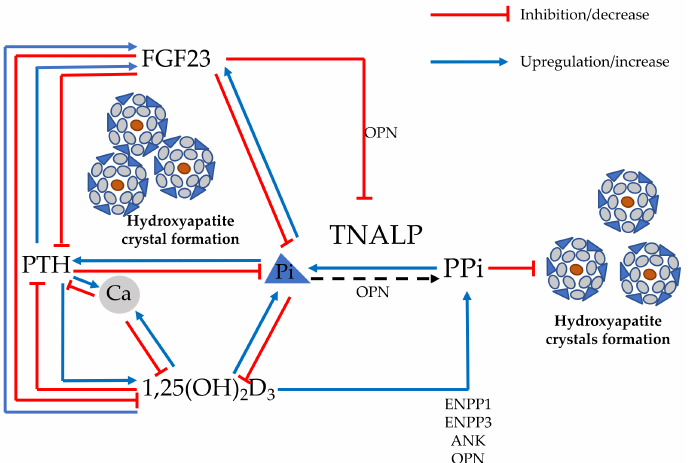
Figure 1. Graphic description of the endocrine and paracrine regulation of the biomineralization pro- cess in and around osteoblast and osteocytes and schematic representation of homeostasis feedbacks. Parathyroid hormone (PTH) and fibroblast growth factor 23 (FGF23) and phosphaturic hormones decrease serum Pi concentration, while 1,25-dihydroxy vitamin D 3 [1,25(OH) 2 D 3 ] increases serum Ca and Pi via active intestinal absorption through activation of the vitamin D receptor. These hormones are reciprocally regulated by negative feedback systems. Tissue non-specific alkaline phosphatase (TNALP) processes inorganic pyrophosphate (PPi), a major inhibitor of mineralization, turning it into Pi, which makes it available for hydroxyapatite crystal formation. At the same time, TNALP depohos- phorylates and activates osteopontin (OPN), which, in turn, inhibits mineralization, increasing PPi. Other mineralization inhibitors include ectonucleotide pyrophosphatase phosphodiesterase 1 and 3 ectonucleotide pyrophosphatase phosphodiesterase 1 and 3 (ENPP1 and 3), which also increase the availability of PPi, similarly to OPN. Active vitamin D inhibits mineralization by increasing intracellular PPi via increasing expression of ENPP1 and 3 and OPN. Extracellular Pi per se inhibits mineralization, likely by increasing OPN. FGF23 decreases mineralization through direct inhibition of transcription of TNALP and through the upregulation of